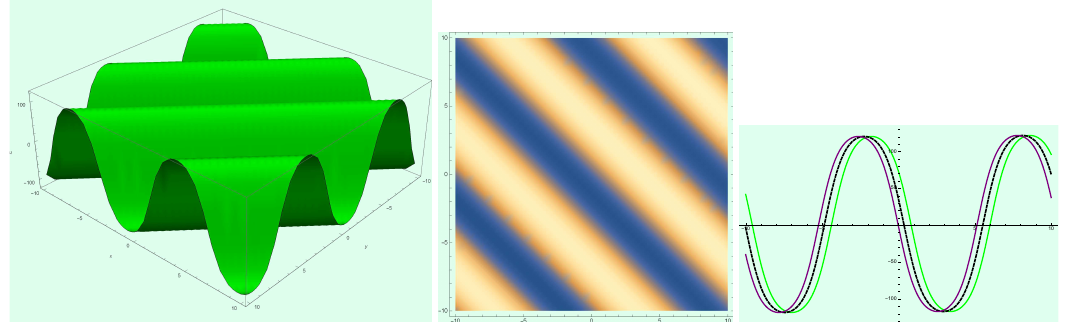
Figure 1. Evolution of periodic solution (20) at t = − 10 and z = − 1.